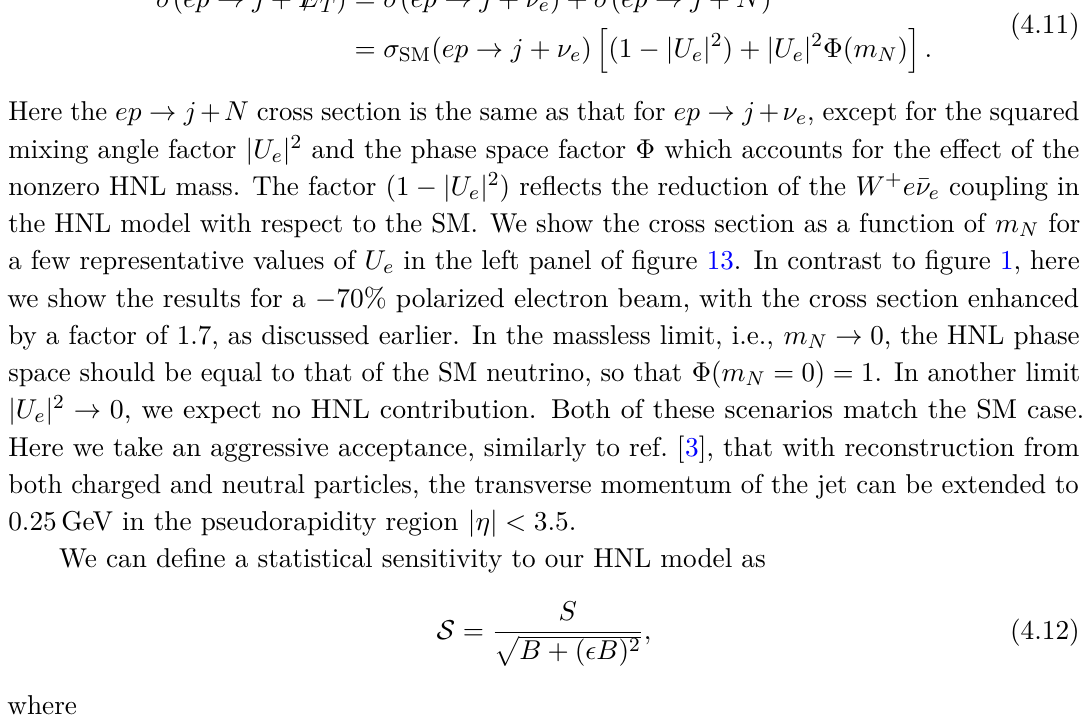
Figure 12 . Jet rapidity η j and transverse momentum p j √ the EIC s = 141 GeV, under the assumption | U e | 2 = 1